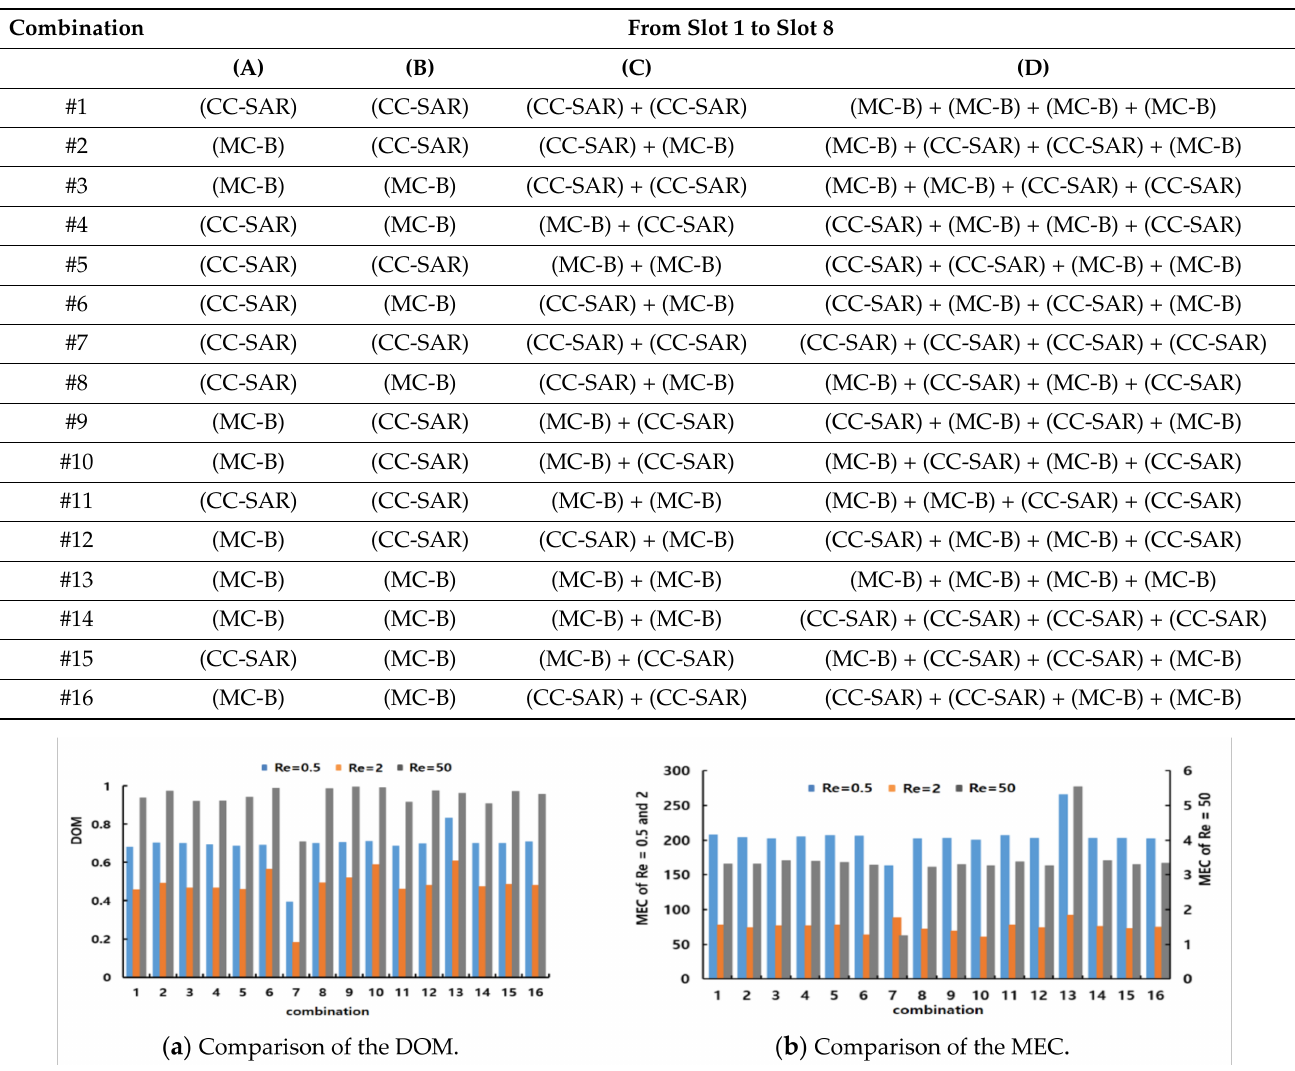
Figure 10. Comparison of the mixing performance of the 16